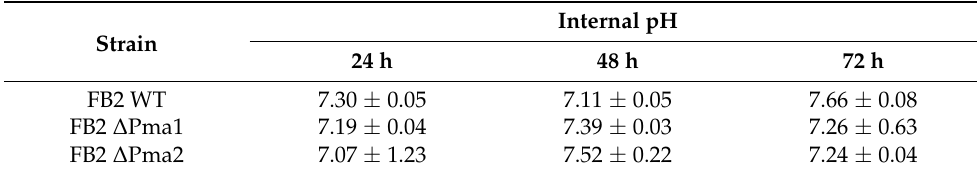
Table 4. Intracellular pH of U. maydis